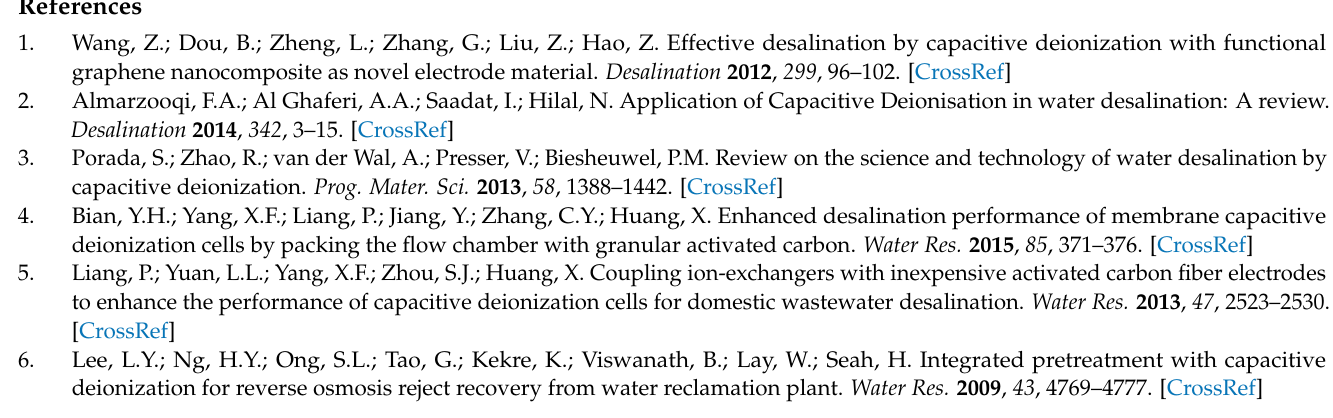
PVDF, Figure S5: EDS of electrode E2b not calendered, thermally treated at 130 ◦ C for 16 h, Figure S6: Zoomed out SEM images of A) Electrode E4 calendered and thermally treated at 130 ◦ C for 16 h and B) Electrode E2b non-calendered and thermally treated at 130 ◦ C for 16 h, shows the difference between calendered and non-calendered electrodes, Figure S7: EDS of electrode E7 thermally treated at 350 ◦ C, Figure S8: Pyrolysis curve for PVDF, Figure S9: DSC of PVDF, indicating partial decomposition around 180 ◦ C. Table S3: Conductivity and current data for JNT45 (substrate), Table S4: Conductivity and current data for E4, Table S5: Conductivity and current data for E6, Table S6 Conductivity and current data for